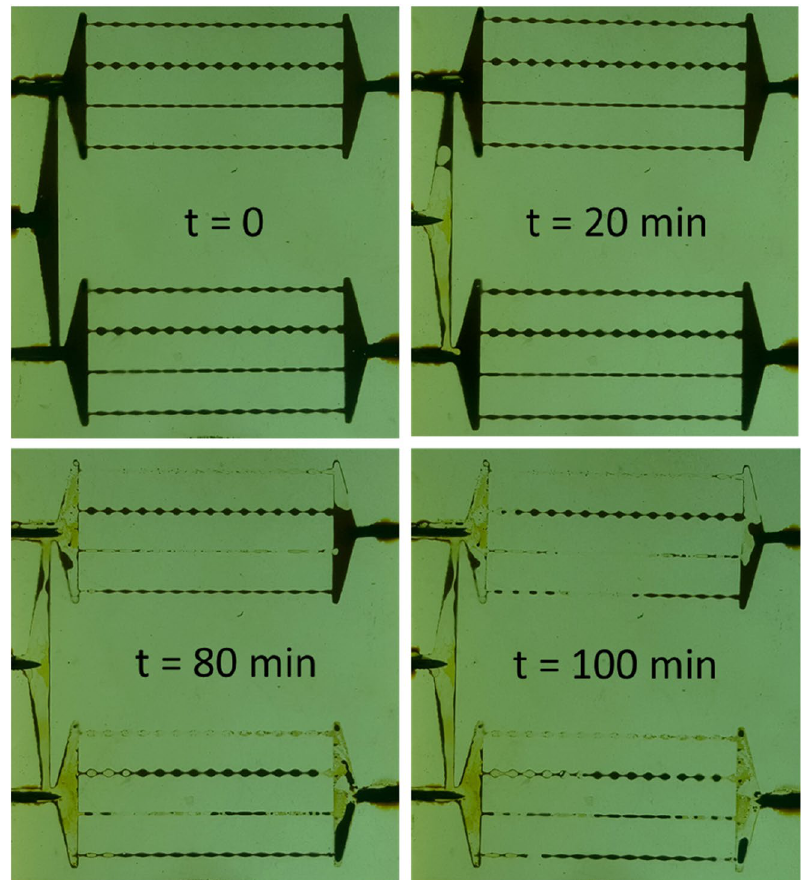
Figure 13. Control flooding experiment of DIW to a fully oil-saturated porous medium at different times. The letter “t” stands for time of flooding. The final photo corresponds to 2 PV injected